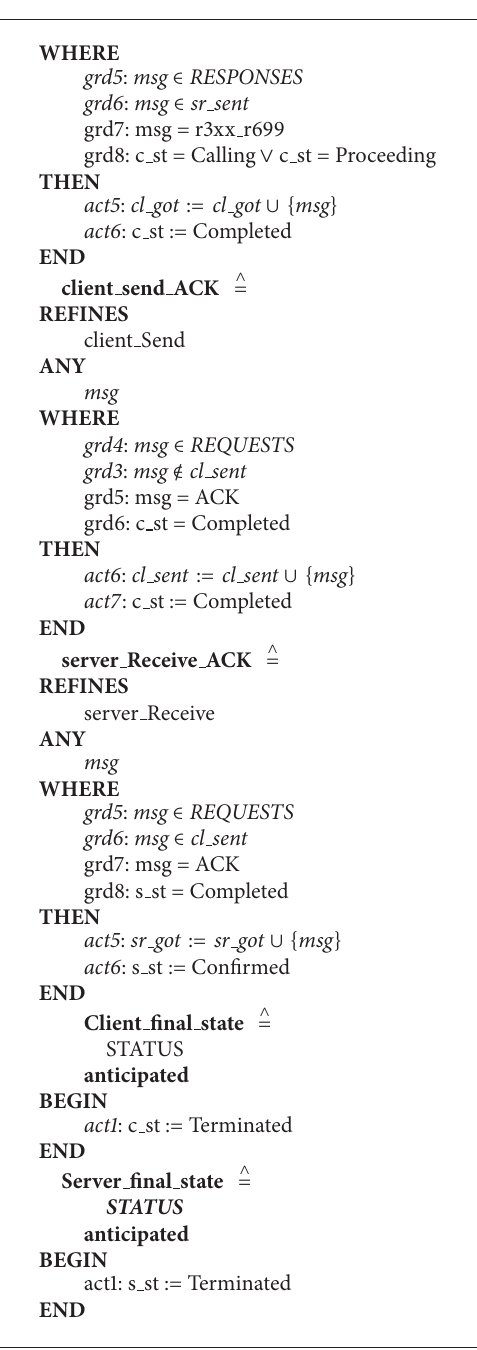
Algorithm 2: Events of first